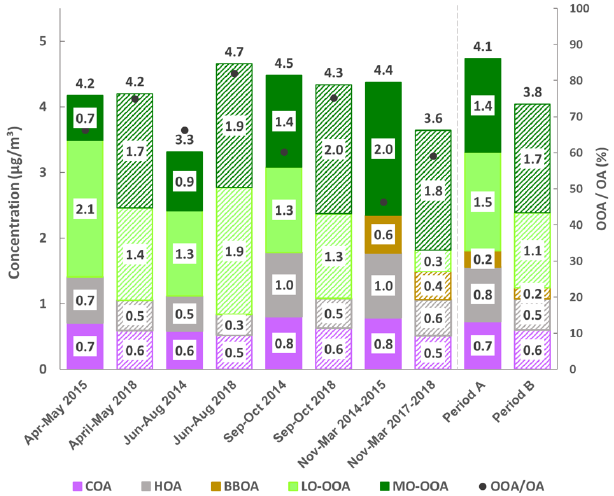
Figure 4. Seasonal OA source apportionment for period A and B (with solid and weft stacked bars, respectively) and OA concen- trations at the top. Markers show the oxygenated organic aerosol proportion with respect to total